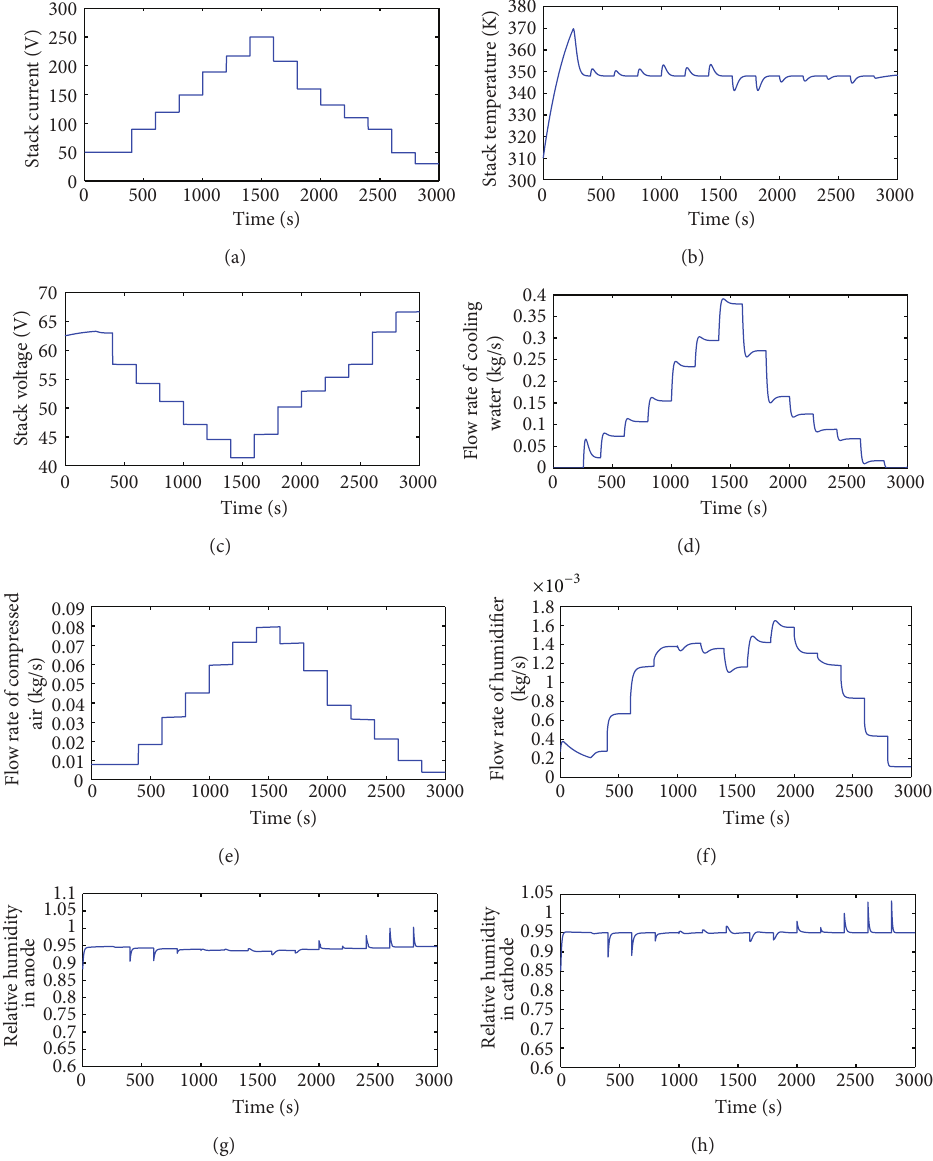
Figure7:SomemeasurementsofdatasetwhichtrainDPLS-basedsoftsensorwhen 𝜙 𝑇 ; (c) stack voltage 𝑉 ; (d) flow rate of cooling water 𝑊 stack st humidity in anode; (h) relative humidity in